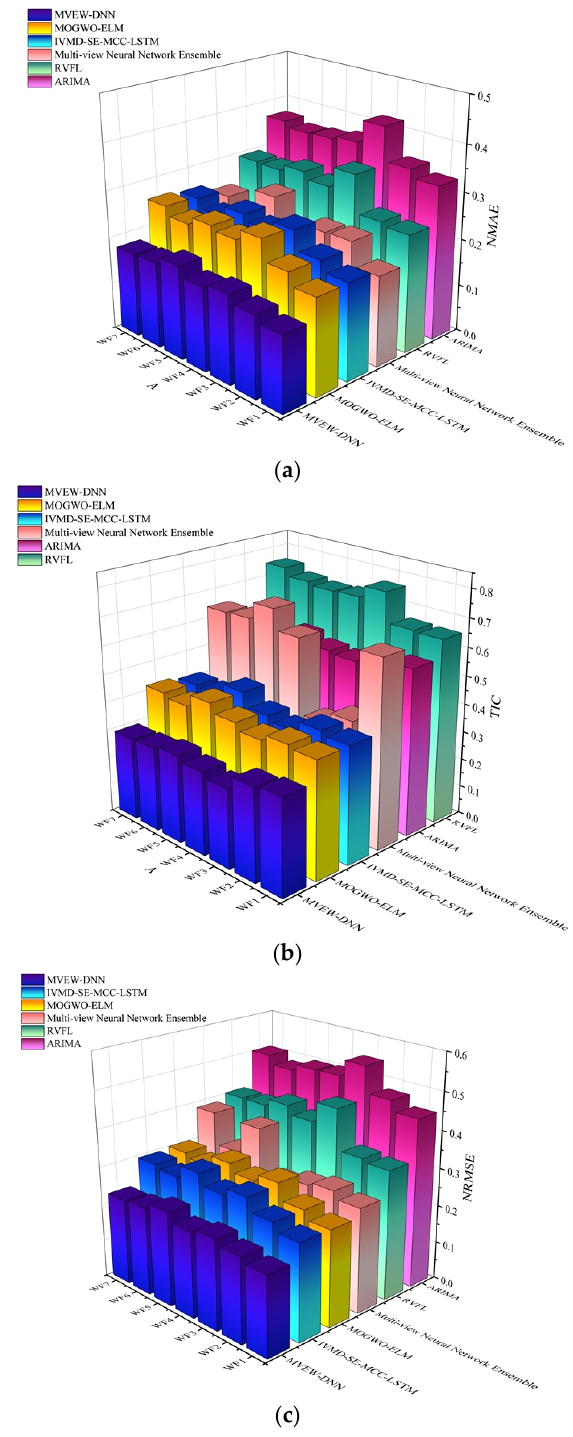
Figure 5. The NRMSE, NMAE, and TIC assessment results: ( a ) comparison of prediction results from 6 models on NMAE; ( b ) comparison of prediction results from 6 models on TIC; ( c ) comparison of prediction results from 6 models on NRMSE.